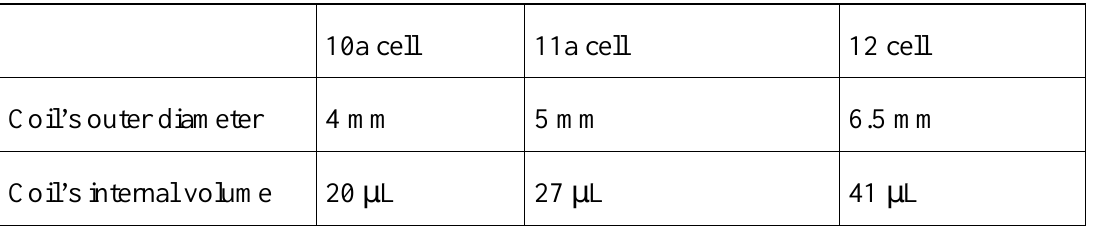
Table 1 . The main characteristics of the selected glass coil-type flow-through